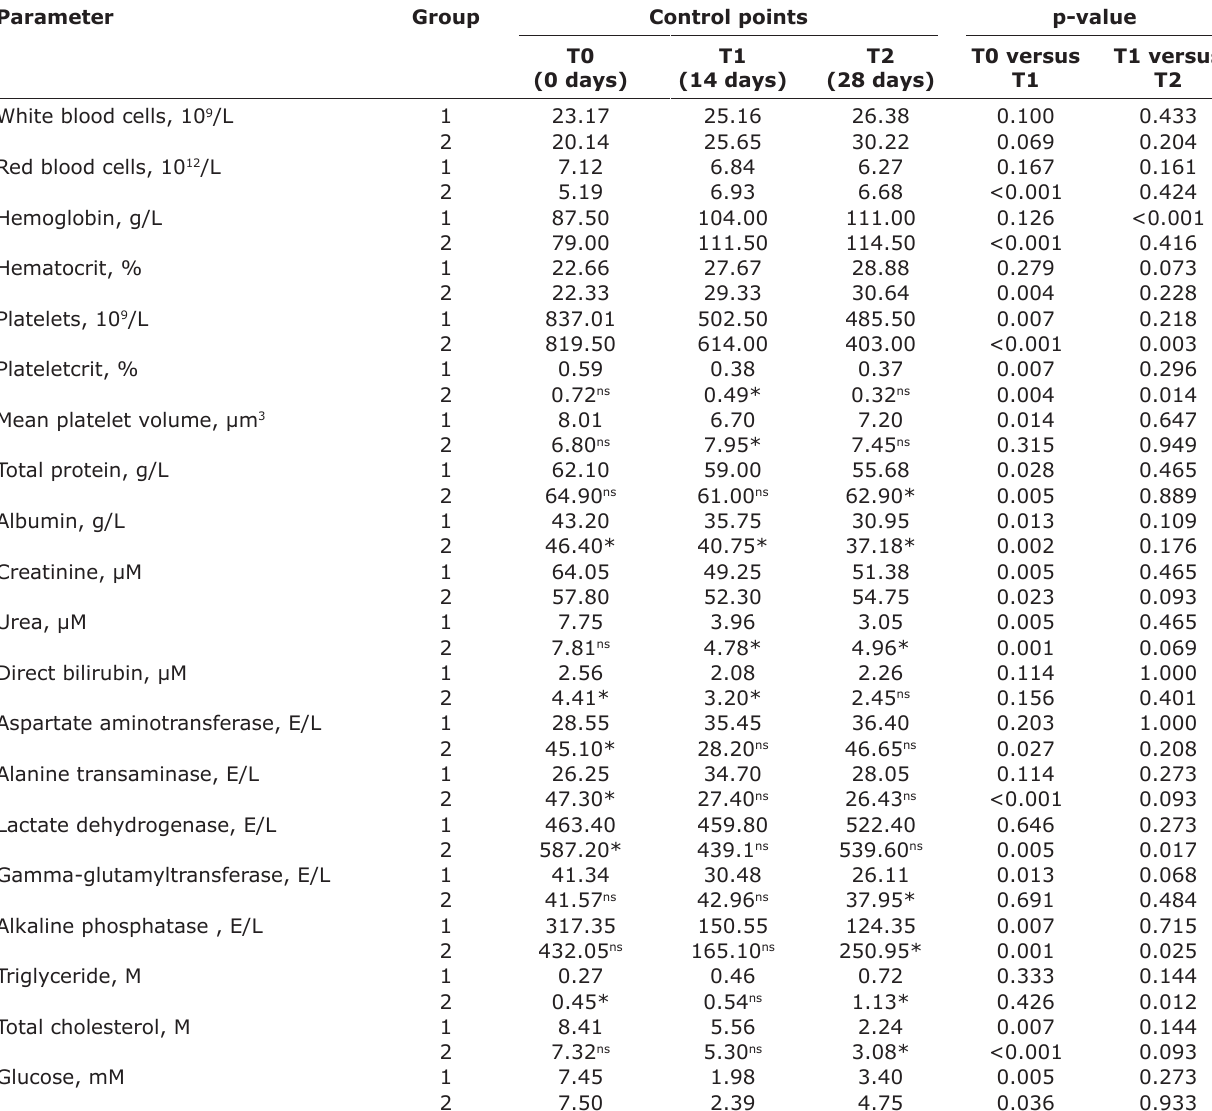
Table-3: Hematological parameters and serum biochemistry of experimental piglets (Me).